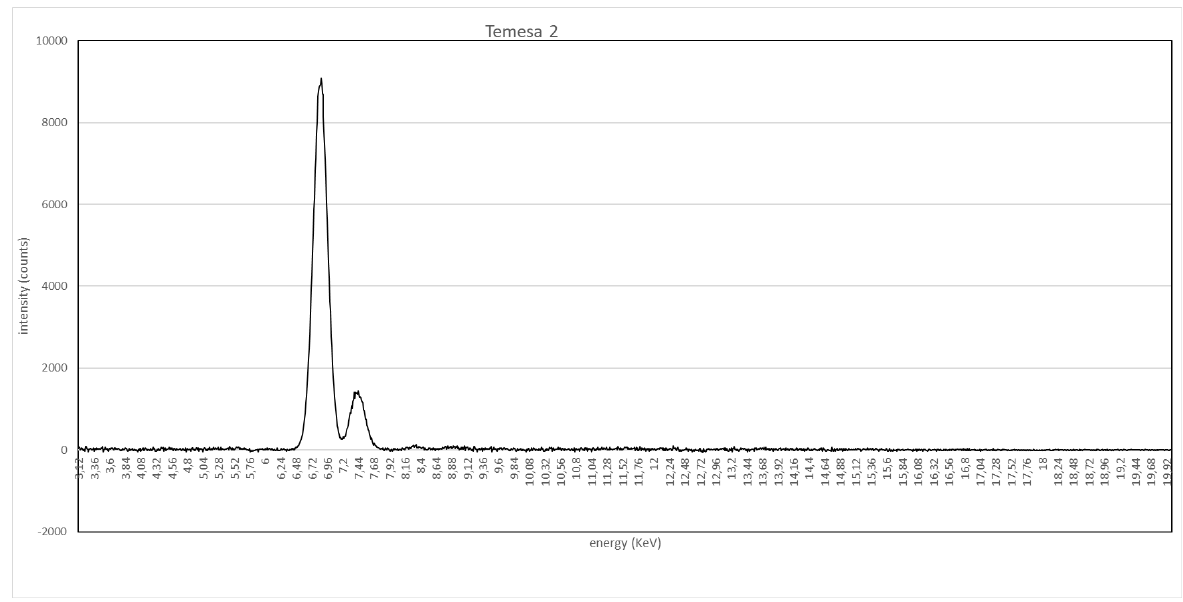
Figure 6. Temesa 2: XRD pattern. Abbreviations: St — stevensite, Fl — phlogopite, Gt — goethite, Cl — chloritoid, Qz — quartz, Di — digenite, Ma — malachite, Cu — cuprite, Fo — fosterite, Te — tetraedrite, Ja — jacobsite, Co — covellite. Square-root intensity scale.